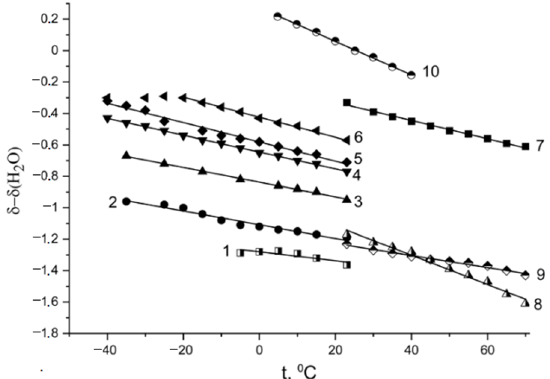
Figure 10. Temperature dependences of the water proton chemical shifts in the Li + , Na + , and Cs + ionic forms of Nafion membranes at various relative humidities, where δ H2O is the bulk water chem- ical shift δ H2O = 4.30 ppm relative to TMS, at 20 °C; Li + ionic form: (1) λ = 0.9, (2) λ = 2.0, (3) λ = 4.0, (4) λ = 5.7, (5) λ = 7.4, (6) λ = 10.7, (7) λ = 12; (8) Na + ionic form: λ = 10; (9) Cs + ionic form: λ = 4; (10) bulk water; λ is the amount of water molecules per sulfonated group. Reprinted with permission from Ref. [60]. Copyright © 2022 Elsevier B.V. All rights reserved. Table 3. Hydration numbers h of Li + cation in the lithium form of the Nafion 117 membrane at different water contents λ . Reprinted with permission from Ref. [60]. Copyright © 2022 Elsevier B.V. All rights reserved.